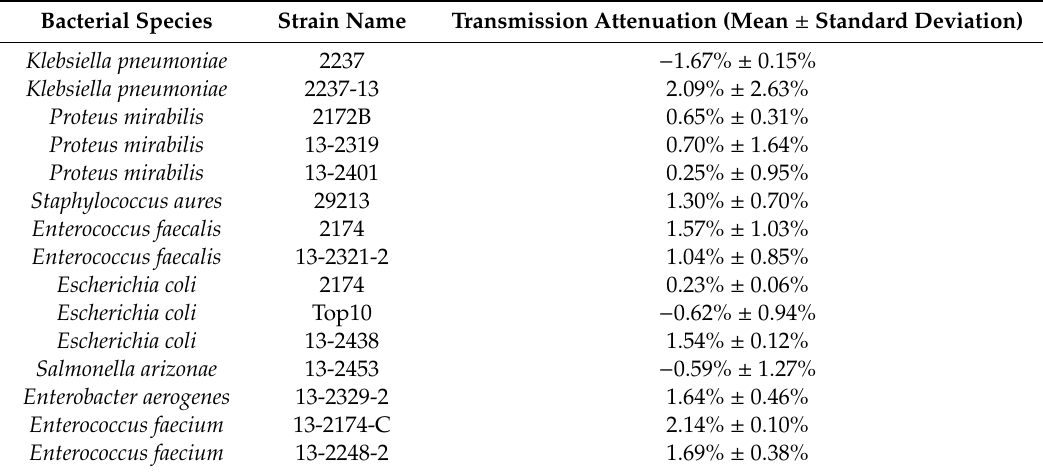
Table 3. Percent NOFS light attenuation from non- Brucella bacterial